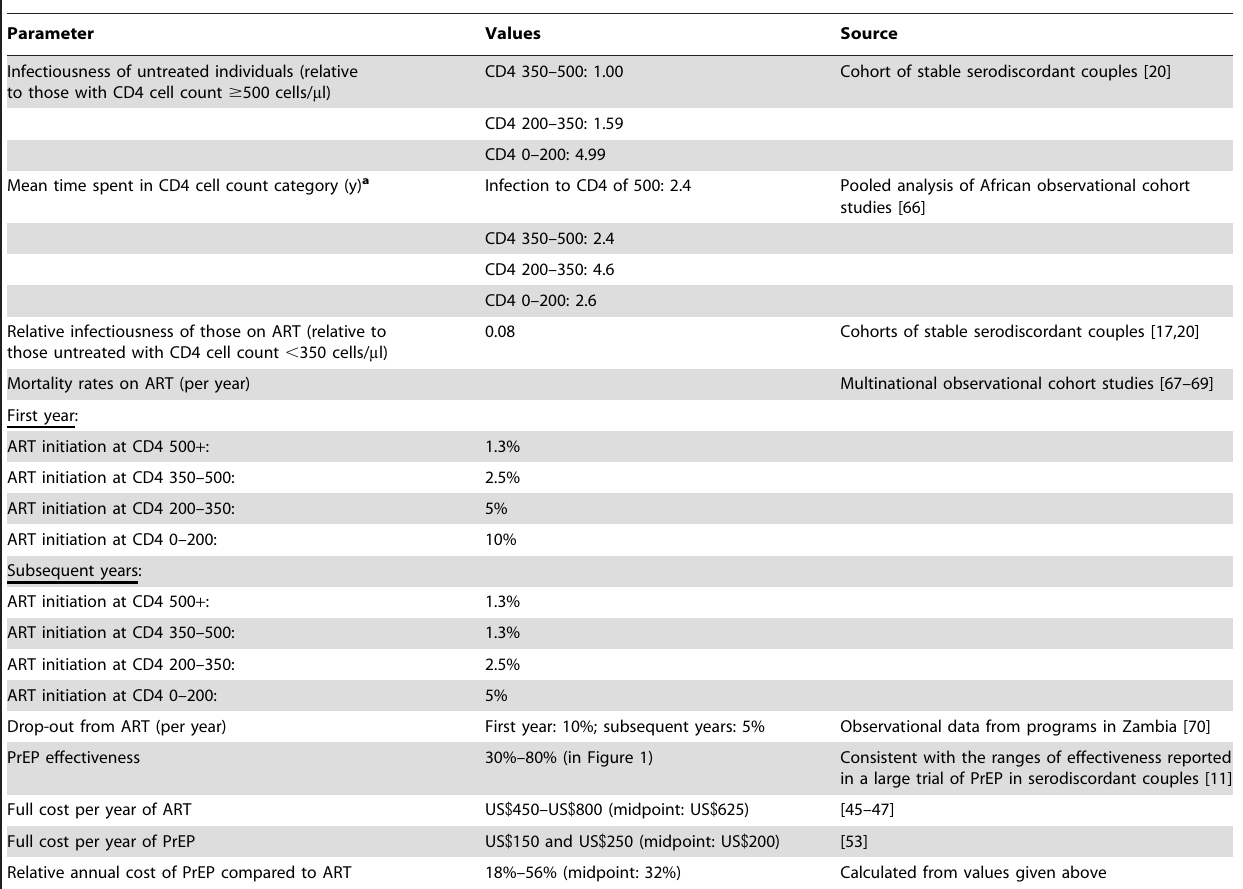
Table 1. Key assumptions made in the model.